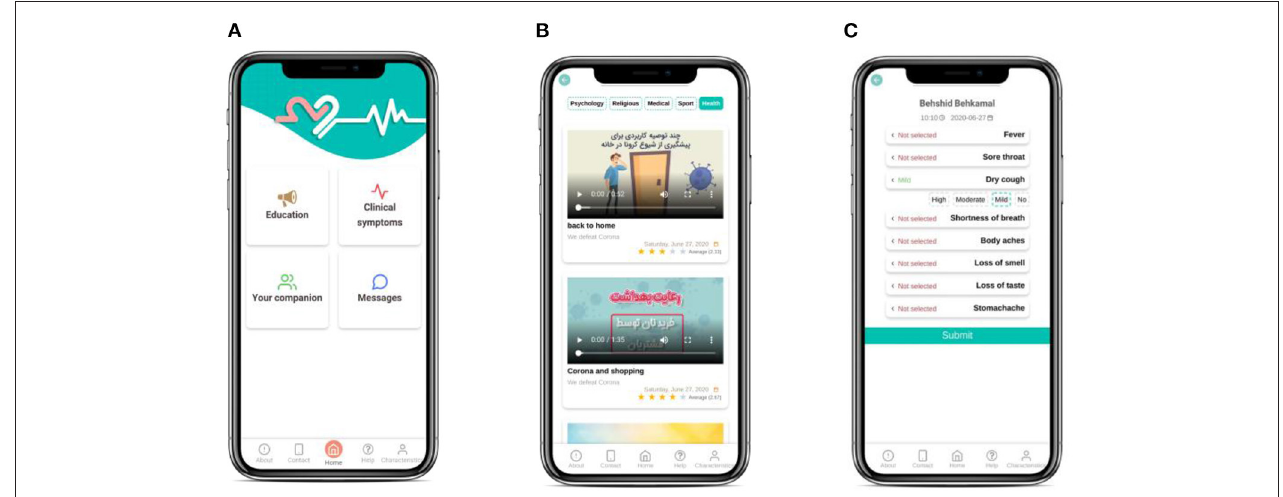
FIGURE 2 | Screenshot of (A) home page view, (B) education, and (C) symptoms